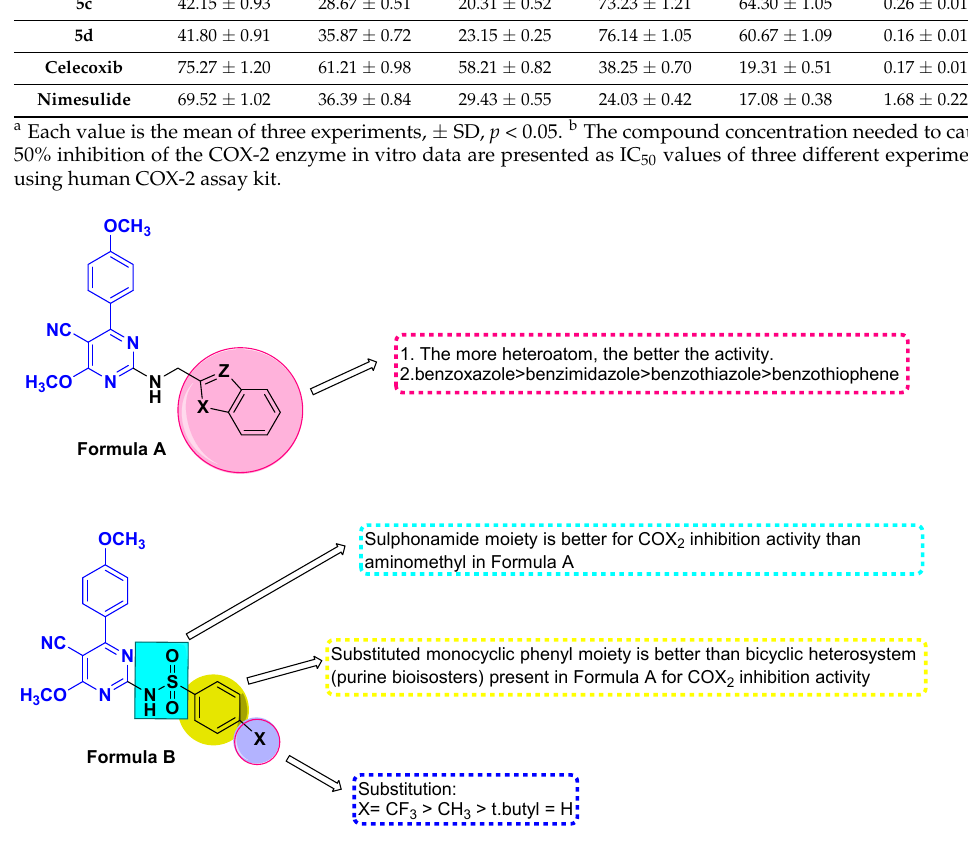
Table 1. In vitro % inhibition at concentrations of 10 − 5 M–10 − 9 M and IC 50 values of the tested compounds 3a – 3d and 5a – 5d as COX-2 inhibitors incomparable with Celecoxib and Nimesulide as refer- ences.